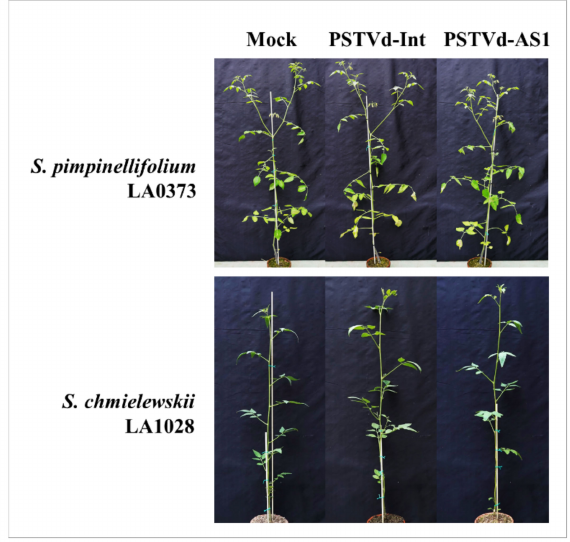
Figure 5. PSTVd tolerance in wild tomato relatives. S. pimpinellifolium LA0373 and S. chmielewskii LA1028 plants exhibited high PSTVd tolerance and did not show any disease symptoms at 6 weeks post-inoculation, even to PSTVd-AS1